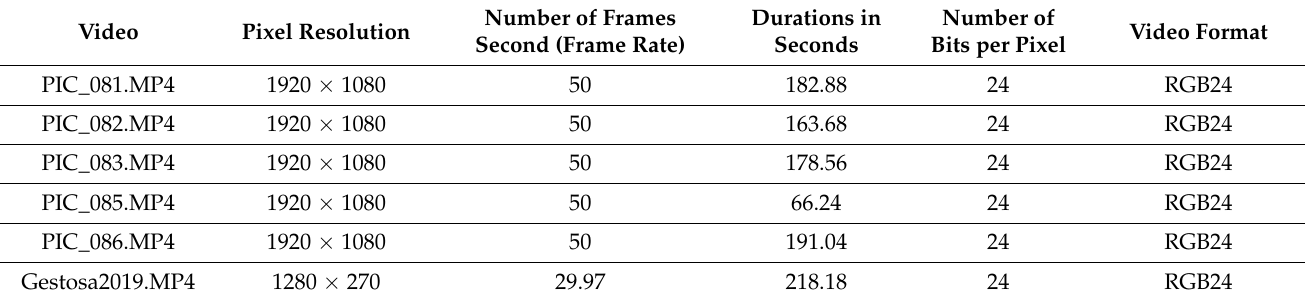
Table 1. Firefront_Gestosa dataset: The first five videos consist of five main recorded videos. The last video is a compilation of multiple perspectives from the first five videos.